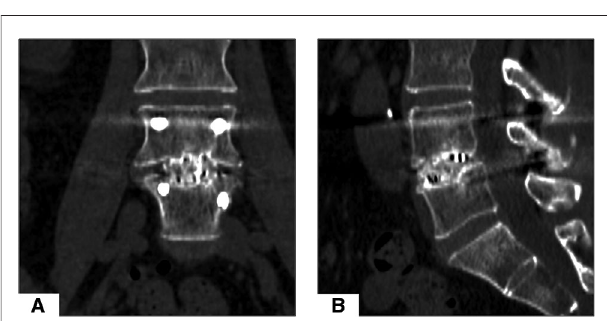
FIGURE 4 | CT scan for three months after surgery. ( A ) Coronary scanning. ( B ) Sagittal scanning.